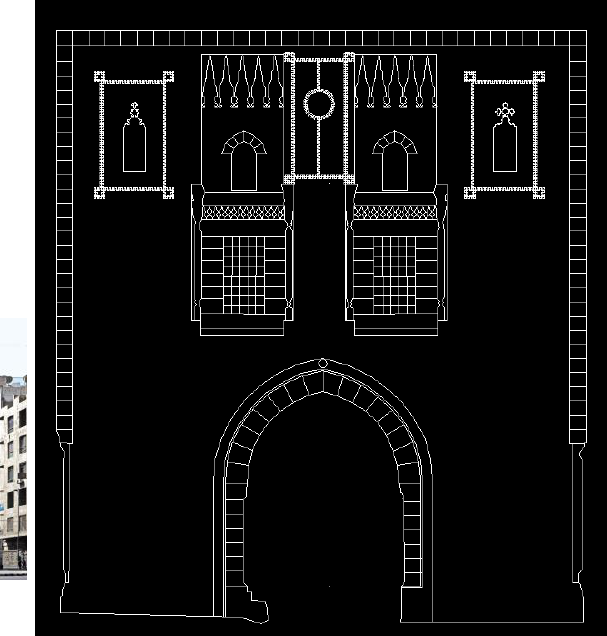
Figure 20 – Damascus, the ottoman railway station